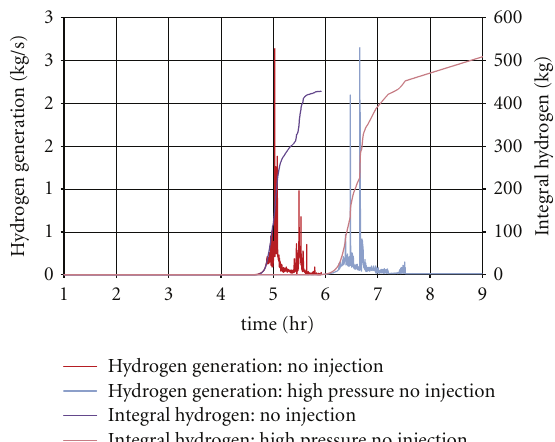
Figure 22: Hydrogen generation rate and integral hydrogen for scenarios with and without water injection after the start of core uncovery (all emergency water injection was terminated at 4.2 hours after reactor